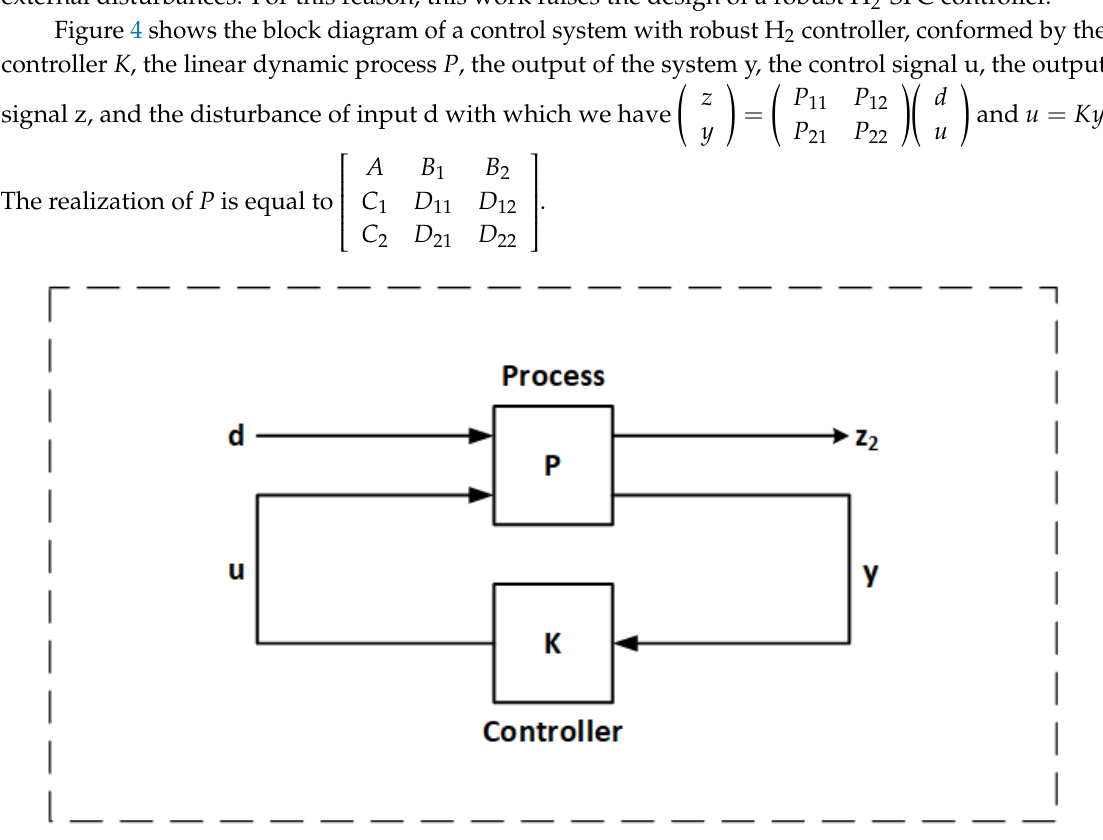
Figure 4. Traditional block diagram of the robust H 2 controller.